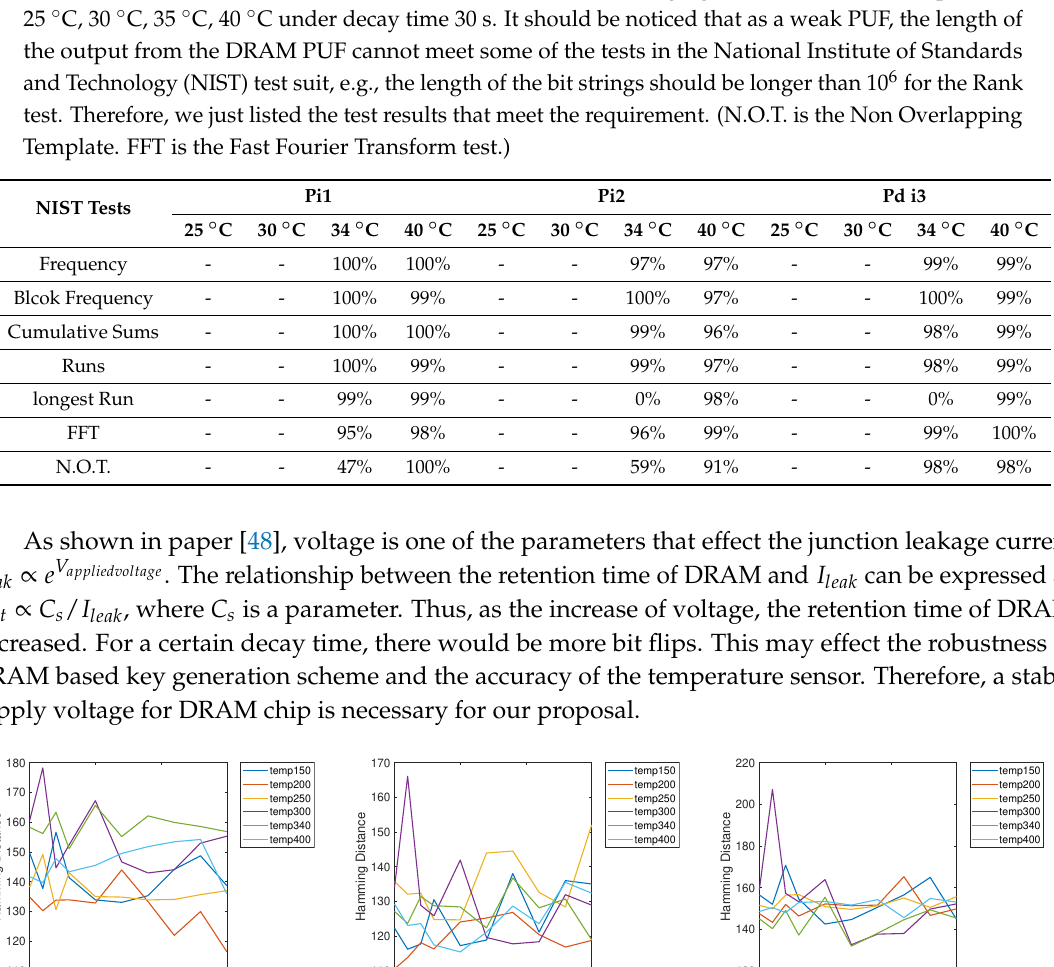
Table 2. The randomness test results for the DRAM PUF leveraging NIST test suit for temperature